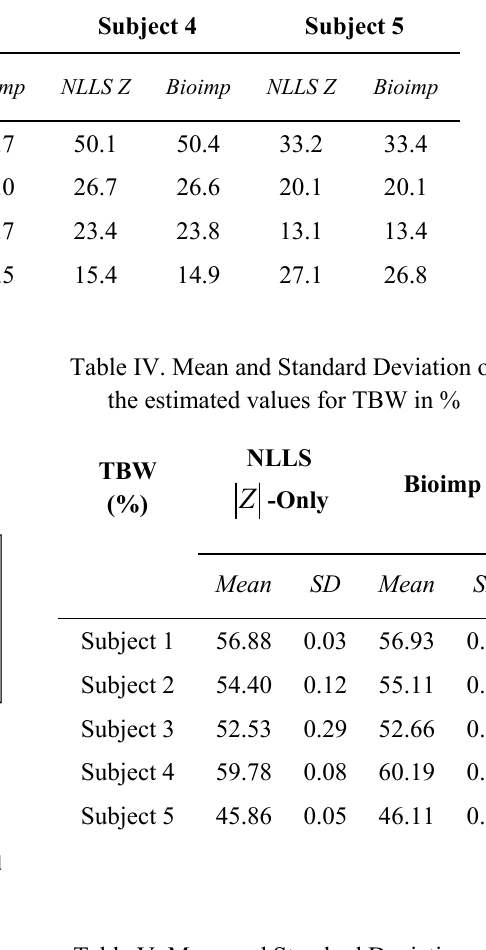
Table III. Mean values for the BCA parameters of each